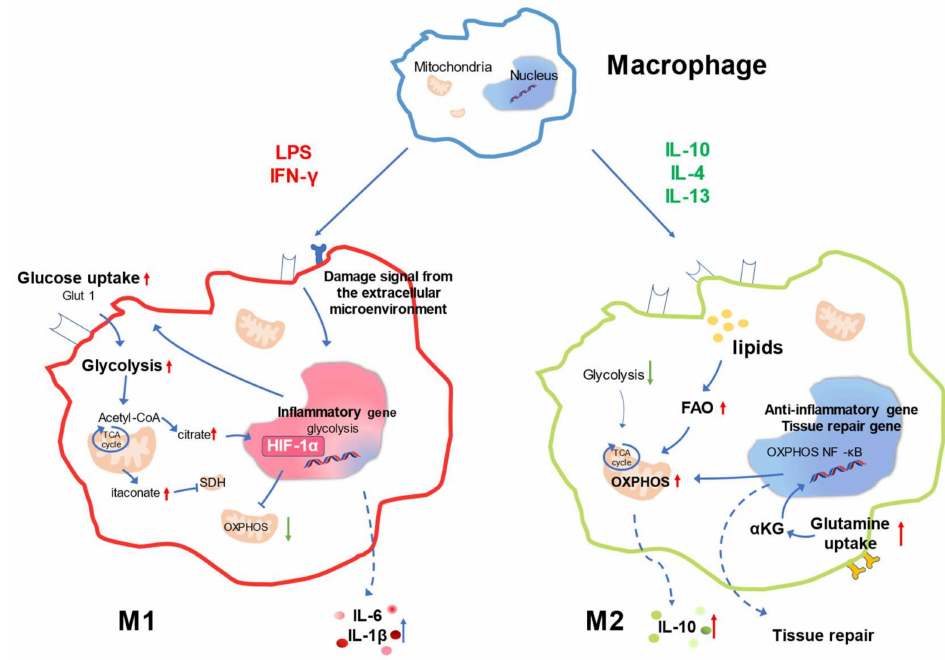
Figure 2. Metabolic reprogramming in macrophage polarization to proinflammatory or alternatively- activated macrophages. Proinflammatory polarization is accompanied by enhanced glycolytic metabolism ( left ), and OXPHOS, FAO, and glutamine metabolism are associated with alternatively- activated macrophages ( right